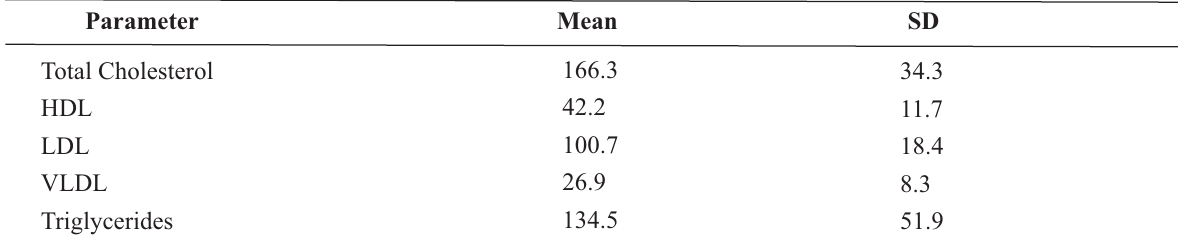
Table 2: Lipid profile of ischemic stroke patients